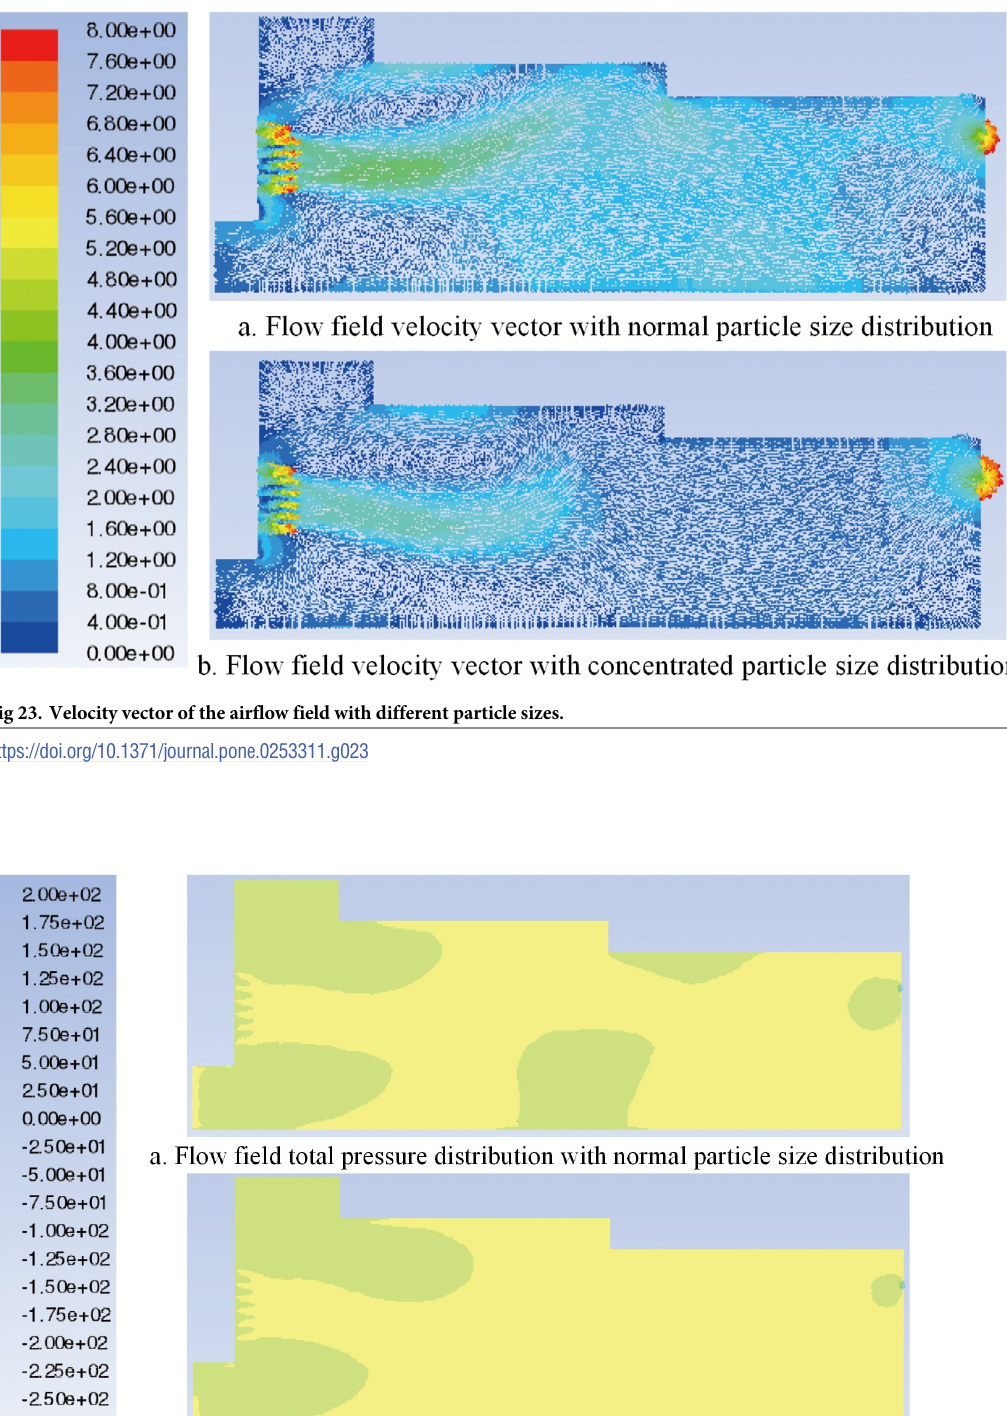
PLOS ONE | https://doi.org/10.1371/journal.pone.0253311 June 17,